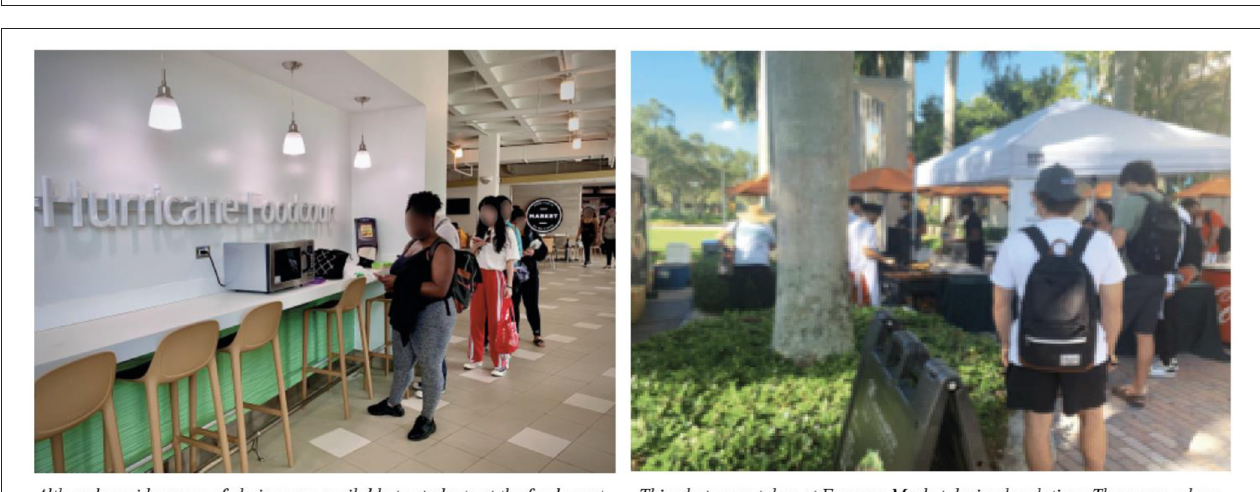
FIGURE 1 | Unhealthiness becomes the norm.